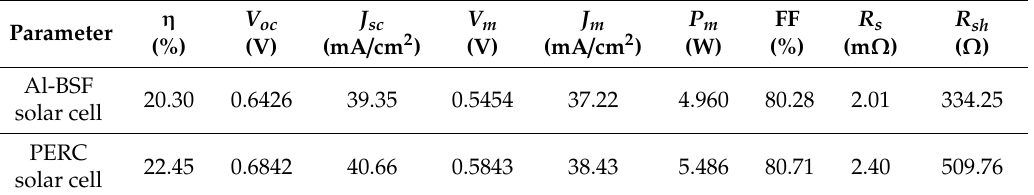
Table 1. The measured parameters of the full-area aluminum back surface field (Al-BSF) solar cell and the passivated emitter and rear cell (PERC) solar cell under standard test conditions (STC).